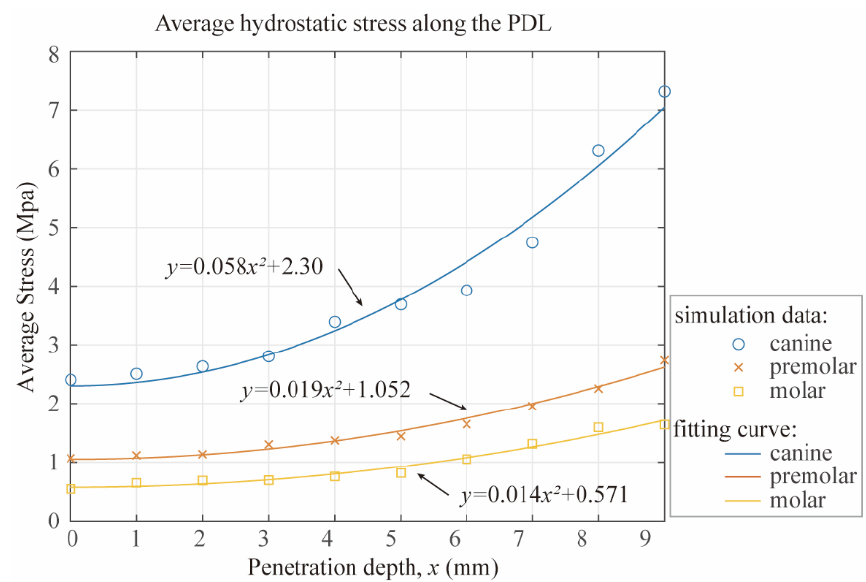
Figure 6. Average hydrostatic stresses along the PDL versus the penetration depths into the MSF for different teeth. Experimental data and the quadratic model fitting.